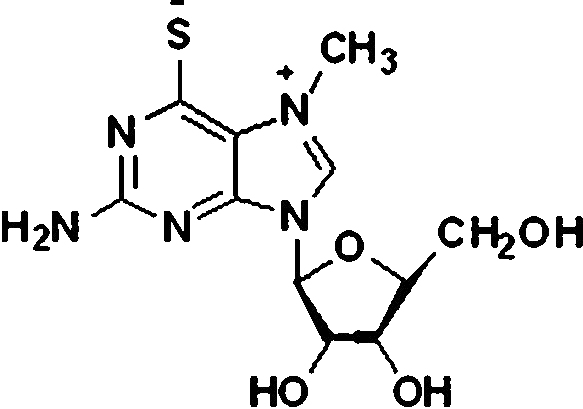
Structure of MESG.